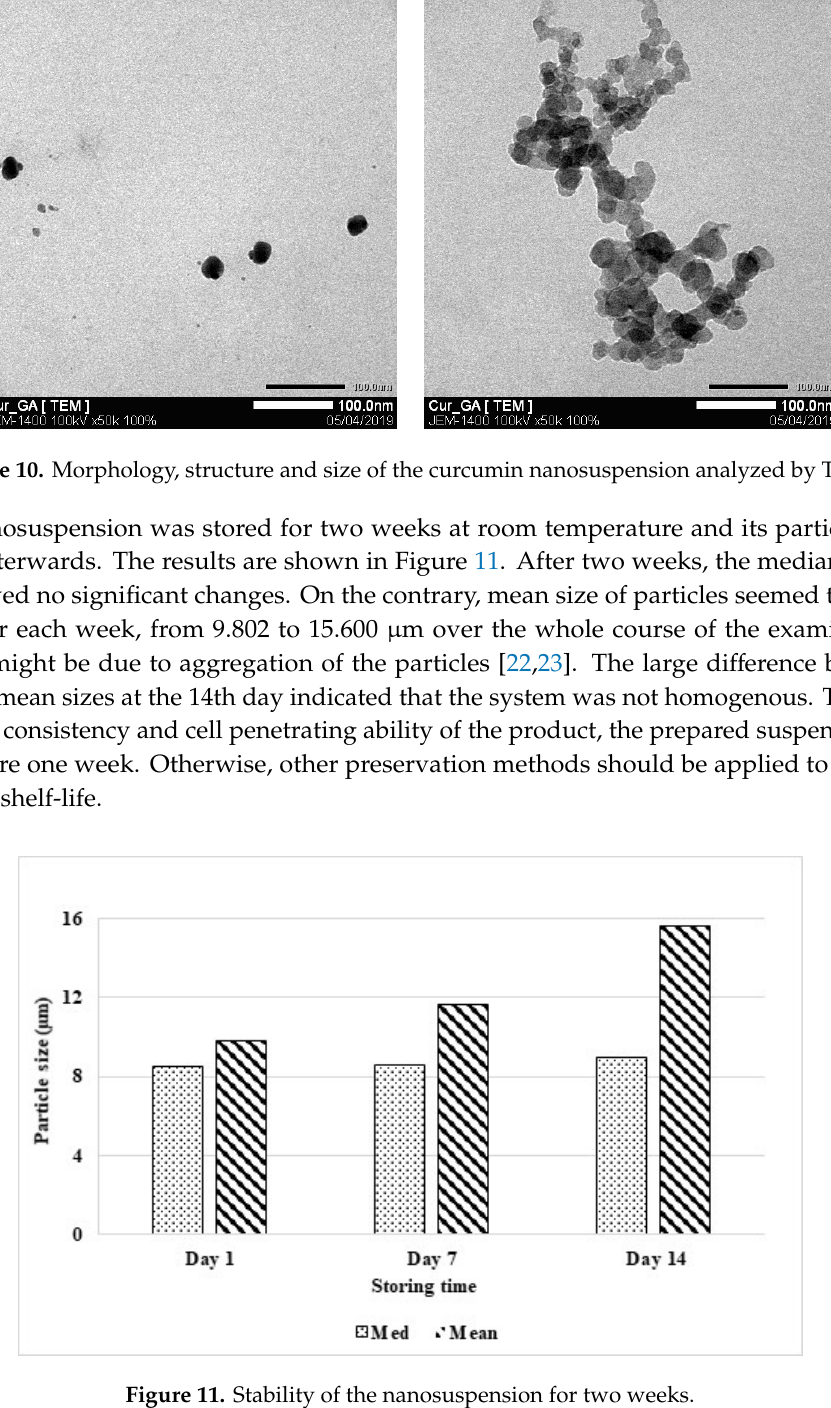
Figure 11. Stability of the nanosuspension for two